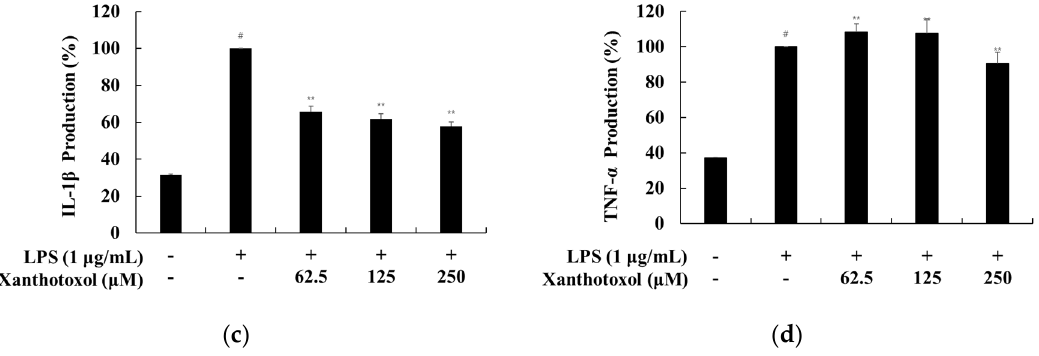
Figure 4. Effect of xanthotoxol on the production of PGE 2 and inflammatory cytokines in LPS-induced RAW 264.7 cells. The cells were treated with xanthotoxol (62.5, 125, and 250 μ M) and LPS (1 μ g/mL) for 24 h. NS-398 was used as a positive control. ( a ) PGE 2 , ( b ) IL-6, ( c ) IL-1 β , and ( d ) TNF- α production were determined by ELISA kit. The results are presented as the mean ± SD from three independent experiments. # p < 0.01 vs. untreated control group. * p < 0.05 and ** p < 0.01 vs. LPS alone.